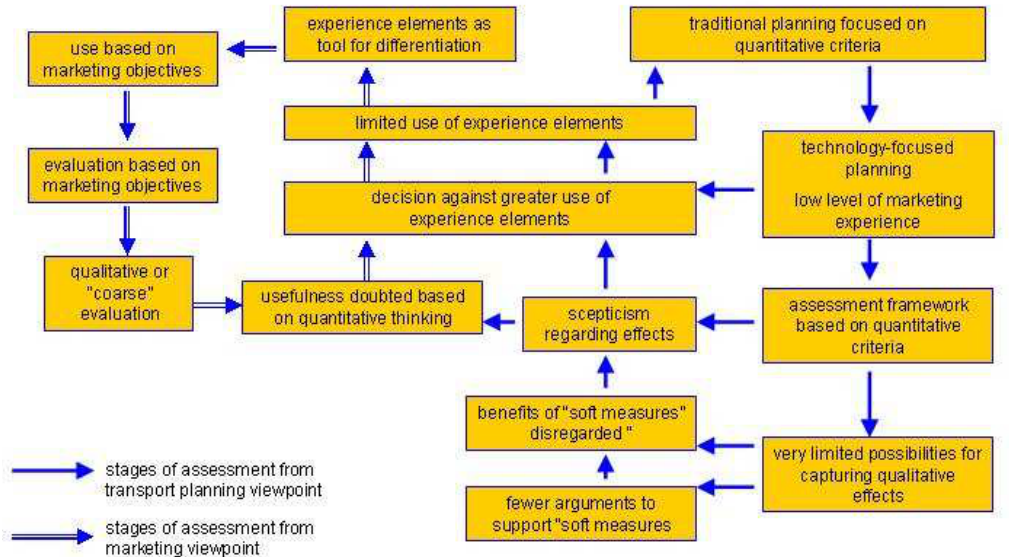
Figure 2. Assessment perspectives supporting limited application of experience measures (author’s depic-